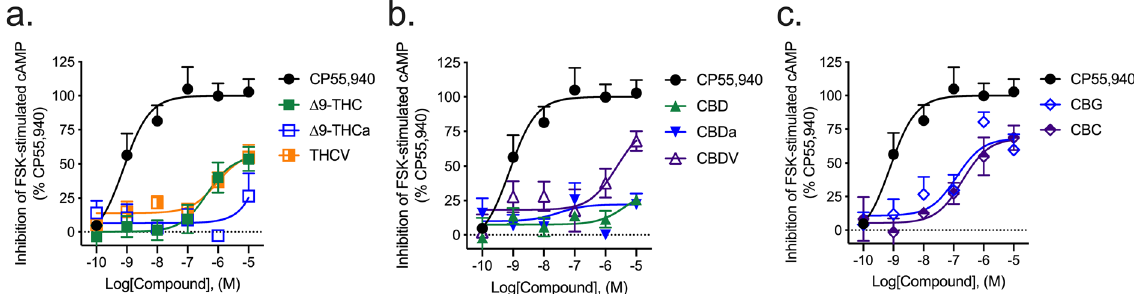
Figure 3. hCB1R-dependent inhibition of FSK-stimulated cAMP accumulation. hCB1R-dependent inhibition of FSK-stimulated cAMP accumulation was quantified in HitHunter CHO cells stably expressing hCB1R and treated with 0.1 nM–10 µM ( a ) THC-like compounds; ( b ) CBD-like compounds; or ( c ) CBG, or CBC for 90 min. Data were fit to a variable slope (4 parameter) non-linear regression in GraphPad (v. 8). n ≥ 6 independent experiments performed in triplicate. E Max refers to the top of the concentration–response curve. Data are expressed as mean ± SEM. EC 50 and E max are reported in Table